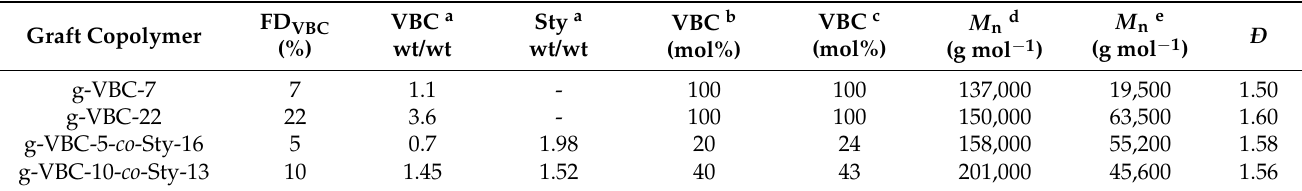
Table 1. Properties of the synthesized